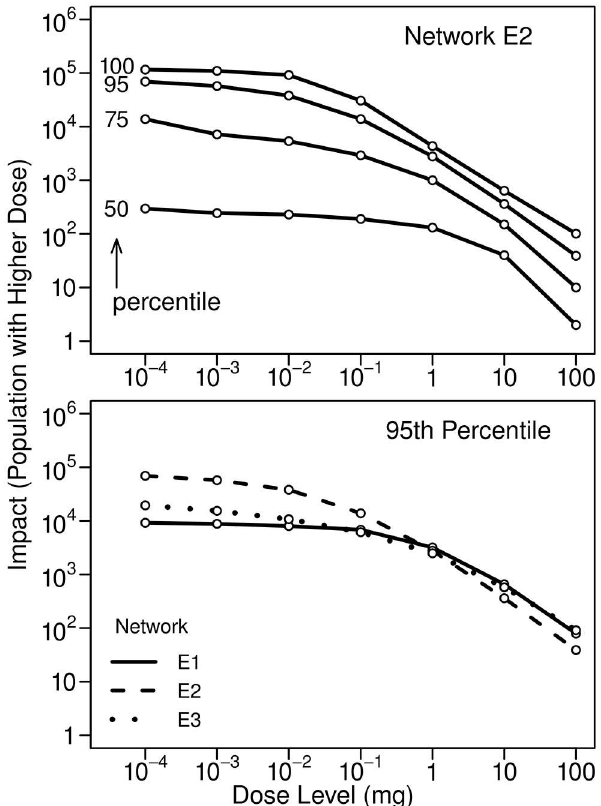
Fig 6. Impacts associated with inhalation of a volatile contaminant during showering. The upper figure shows 50th to 100th percentile impacts for Network E2. The lower figure compares95th percentileimpacts for the three networks. Ten kilograms of contaminant was injected at 0:00 hours for all three